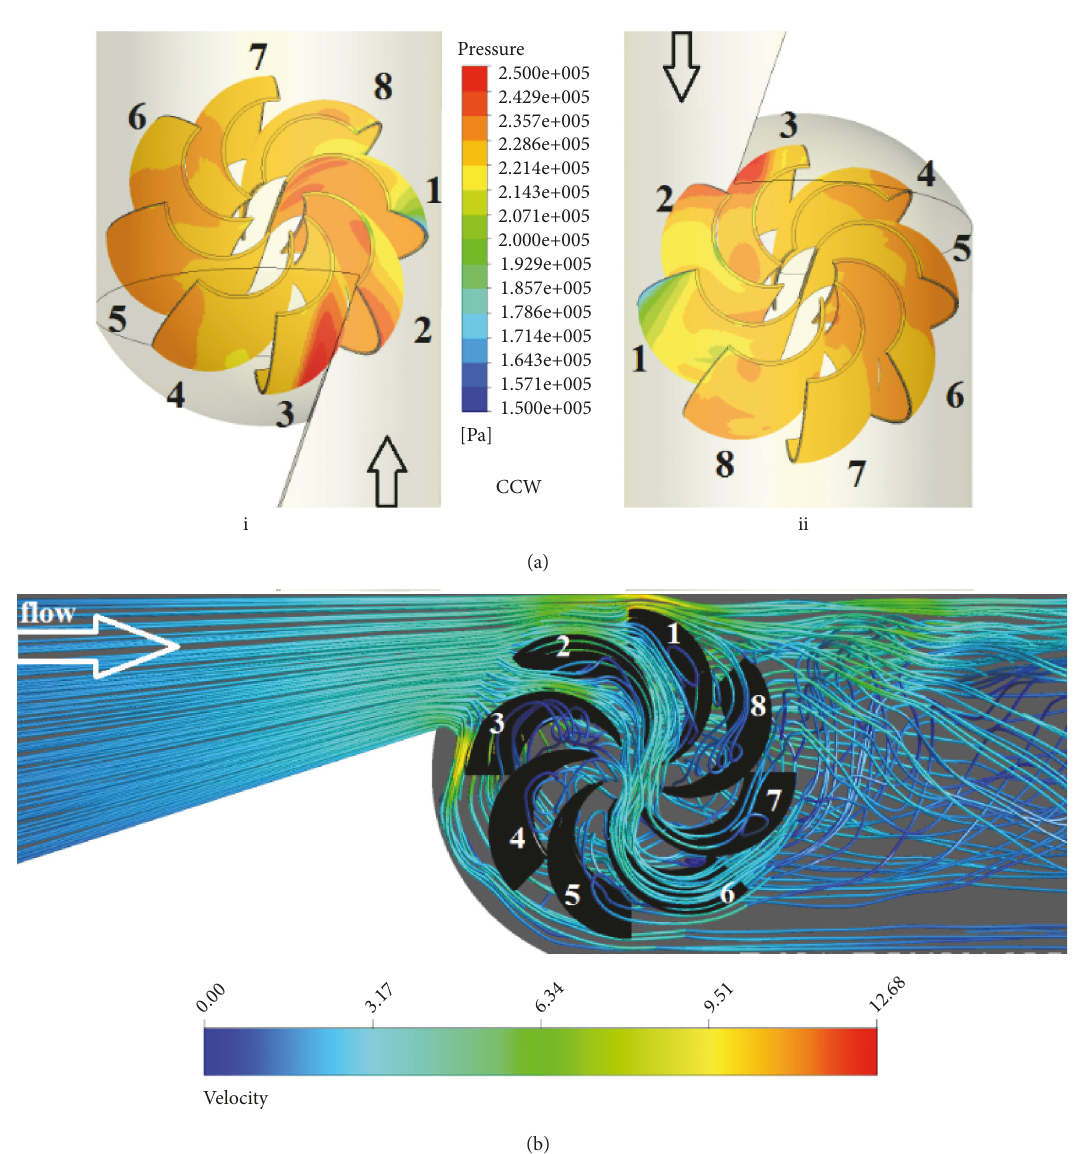
Figure 12: The simulated flow field around the 8-bladed turbine. (a) Pressure contours(i) in the direction of flow view and (ii) in the opposite direction of flow view and (b) top view of